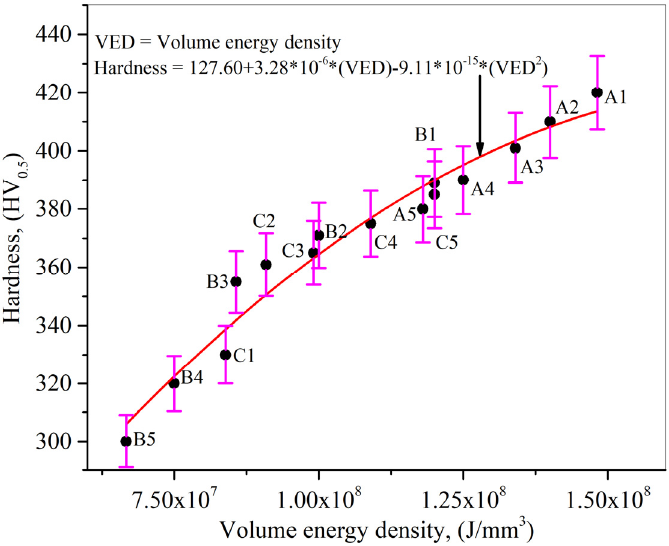
Figure 16. Correlation between volume energy density and Vickers hardness value.